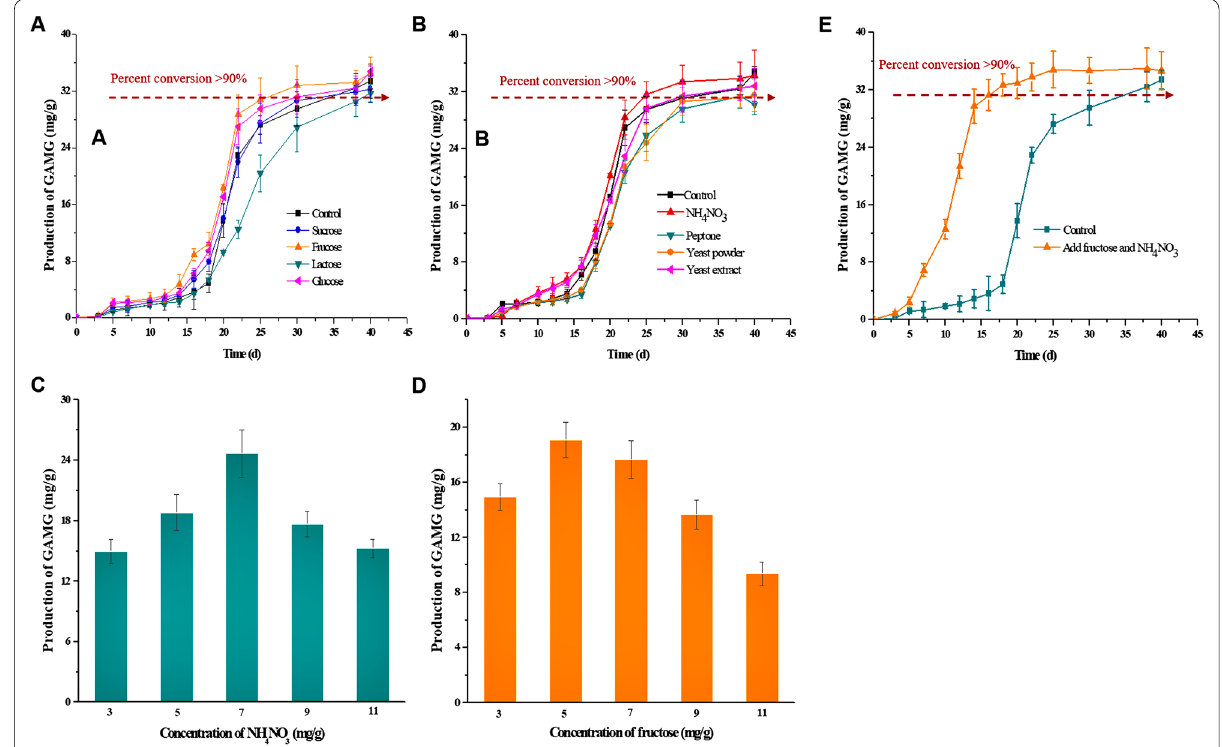
Fig. 4 Effect of nitrogen and carbon sources on GAMG production. Yield of GAMG profile with the addition of A different nitrogen sources, B various carbon sources, C different concentration of NH 4 NO 3 , D different concentration of fructose and E under optimal fermentation